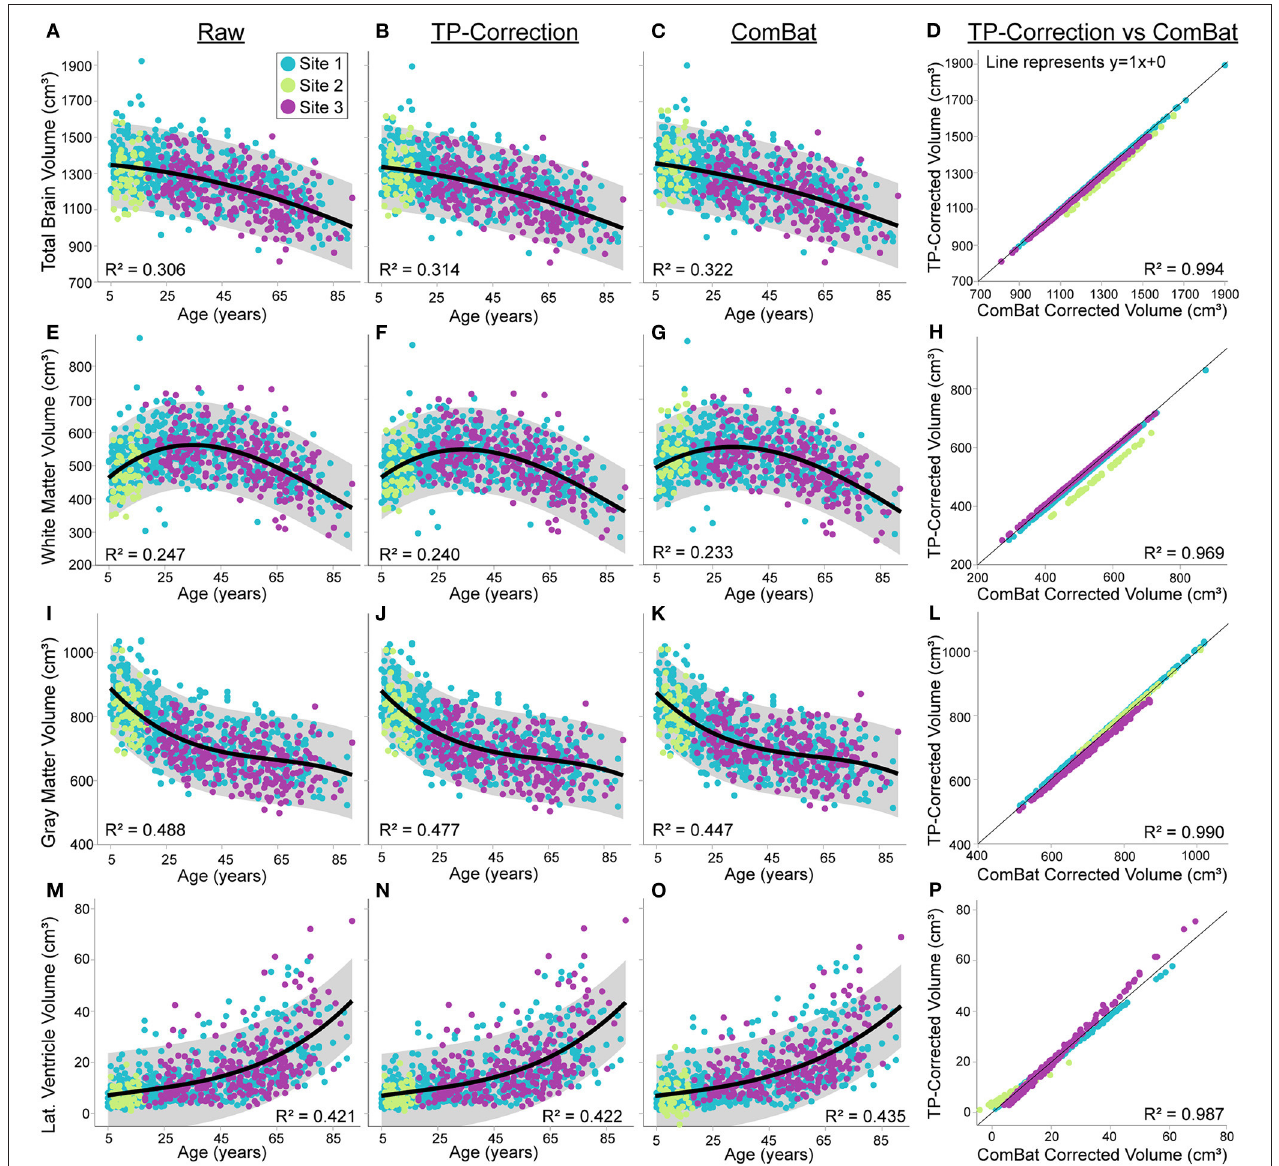
FIGURE 4 | Total brain, white matter, gray matter and lateral ventricle volume across the lifespan in 856 healthy participants (5—91 years of age) scanned at the three sites [Site 1 (UofA) – blue, Site 2 (ACH) – light green, Site 3 (FMC) – purple] before (column 1) and after traveling phantom based correction (column 2) or ComBat correction (column 3). Gray shaded regions indicate the 95% confidence interval for each fit. Column 4 indicates that volumes after traveling phantom (TP) based correction and ComBat based correction are highly correlated, but site–specific differences are observable particularly for white matter and lateral ventricle volumes. Specifically, the correlation between traveling phantom corrected and ComBat corrected volumes at Site 2 (ACH) is right shifted for white matter, and has a shallower slope for lateral ventricles (suggesting an interaction with age). Trajectories and correlations are shown for total brain (A–D) , white matter (E–H) , gray matter (I–L) and lateral ventricle volumes (M–P)